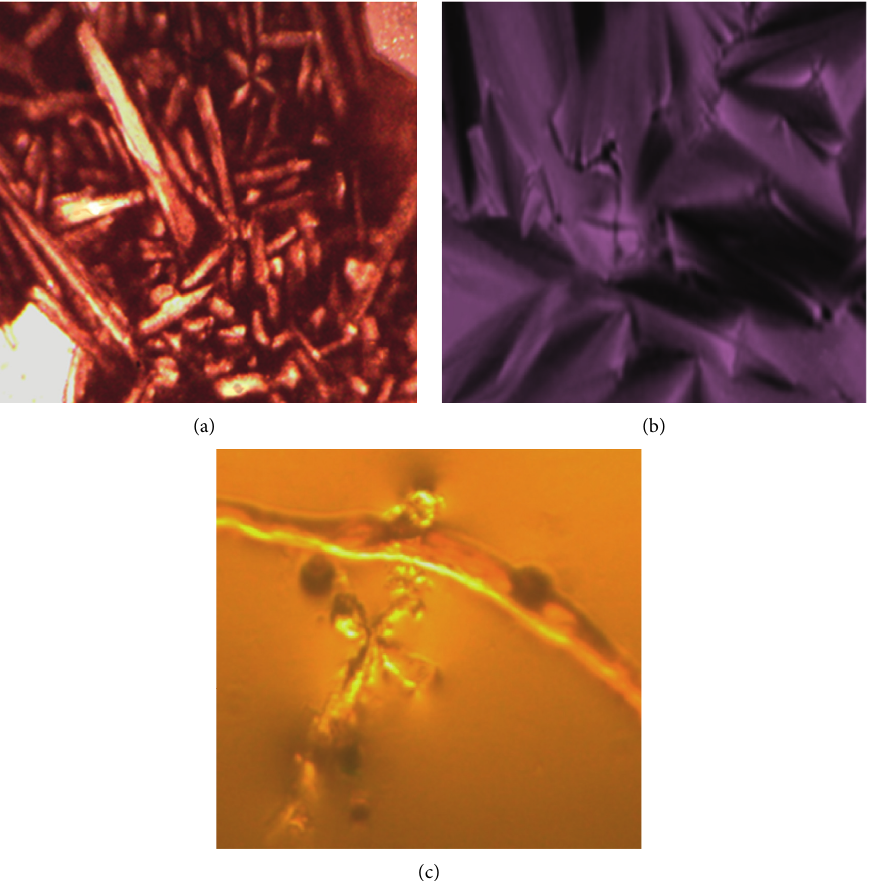
Figure 10: Optical photomicrographs of (a) compound 5e (110 ° C, 10x), (b) compound 5h (85 ° C, 10x), and (c) compound 5k (90 ° C, 10x) showing mesophase